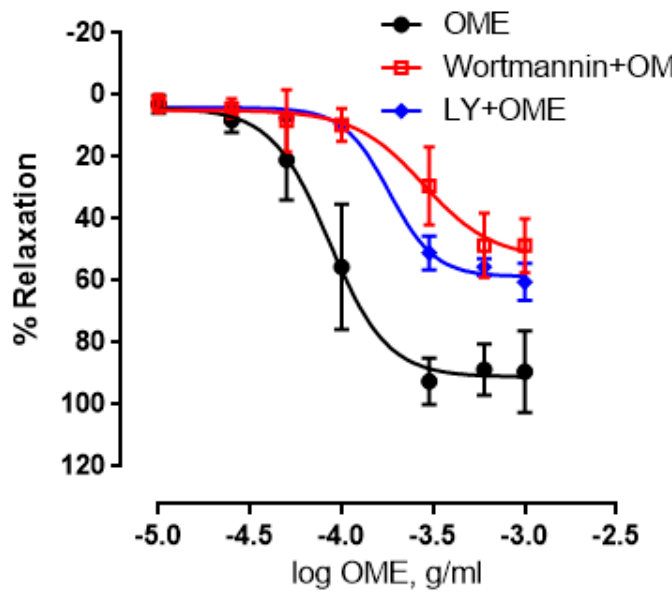
Figure 5. Effect of the PI3K pathway on OME-induced vasorelaxation. Rings with intact endothelium were treated with OME in the absence (black) or presence of phosphoinositide 3-kinase (PI3-K) inhibitors: Wortmannin (0.1 µM; red) or LY29400 (10 µM; blue). Data presented as mean ± SEM ( n = 5; p < 0.01 for OME vs. Wortmannin + OME or LY29400 + OME).